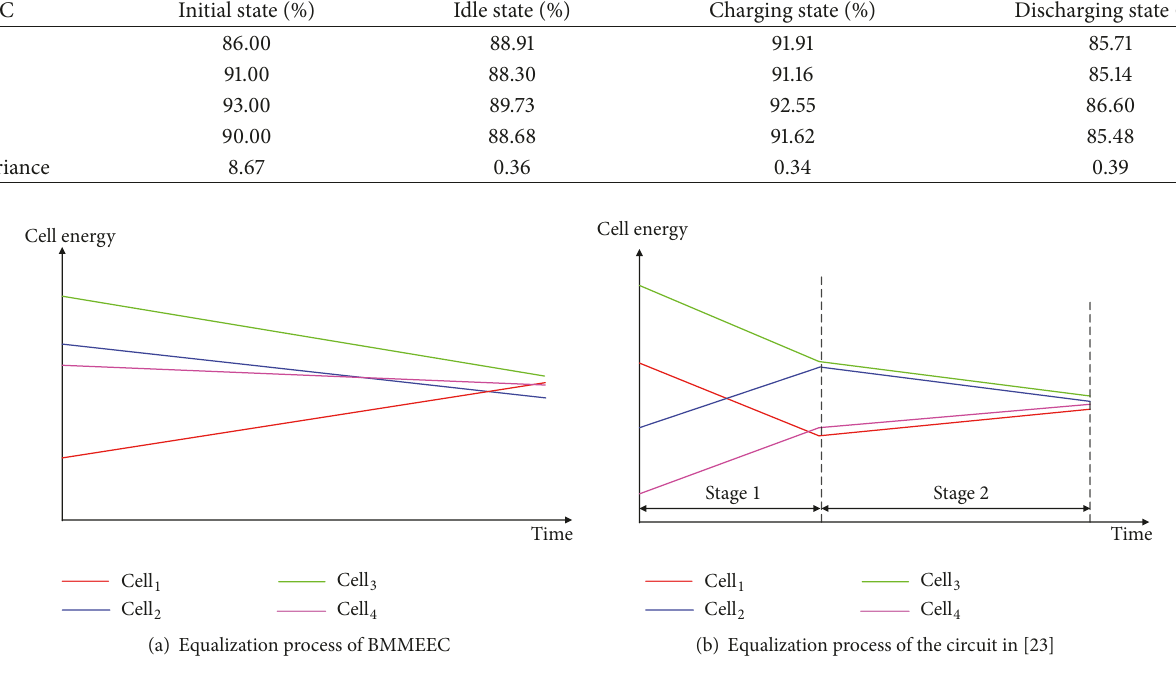
Figure 12: Balancing process comparison between BMMEEC and the circuit in